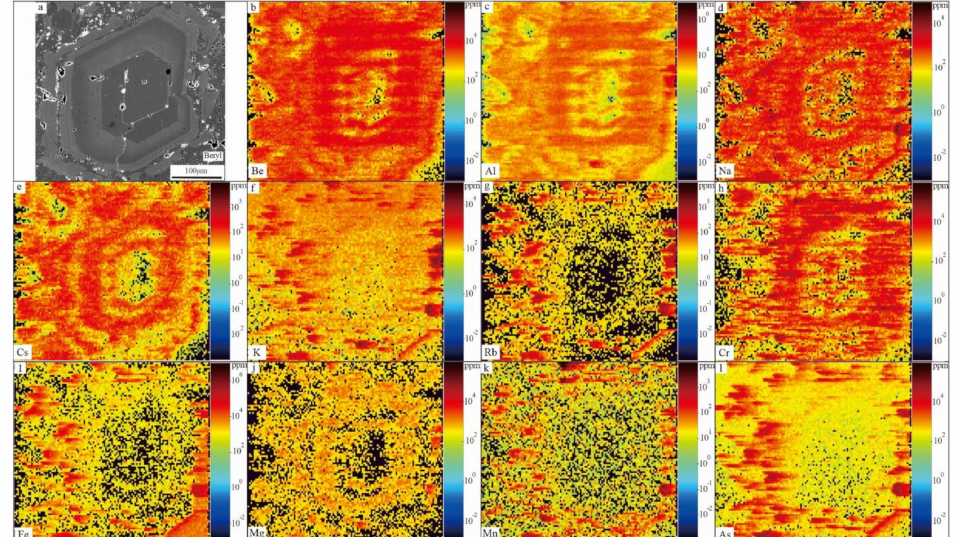
Figure 7. Backscattered electron image ( a ) and LA-ICP-MS mapping images ( b – l ) of beryl-II from the hydrothermal